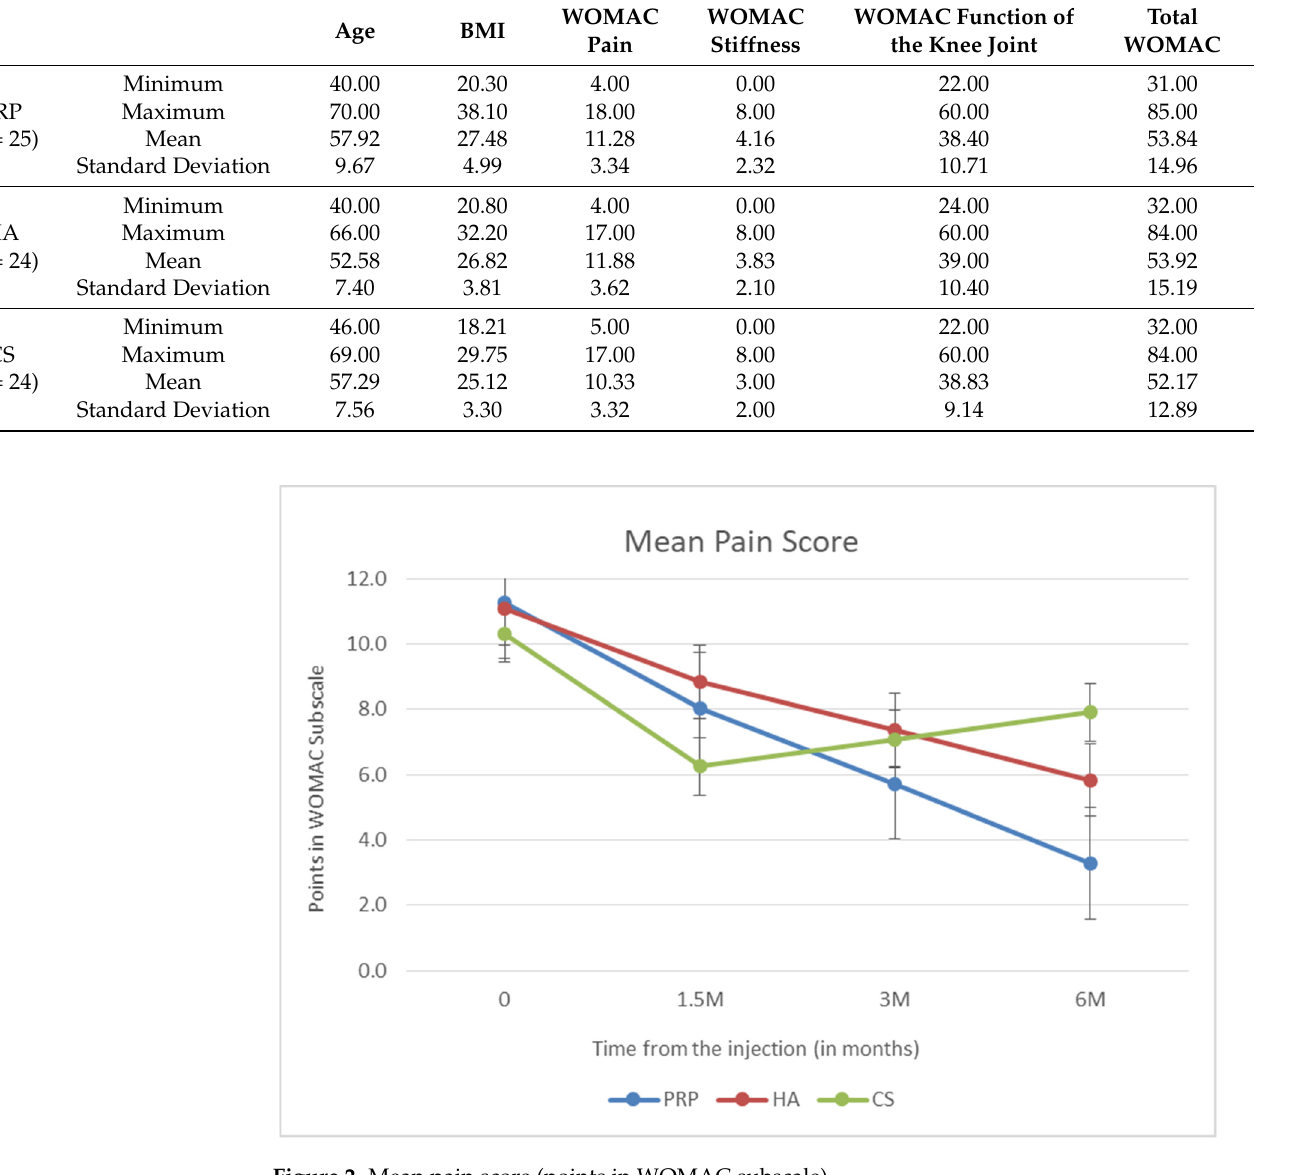
Figure 2. Mean pain score (points in WOMAC subscale).